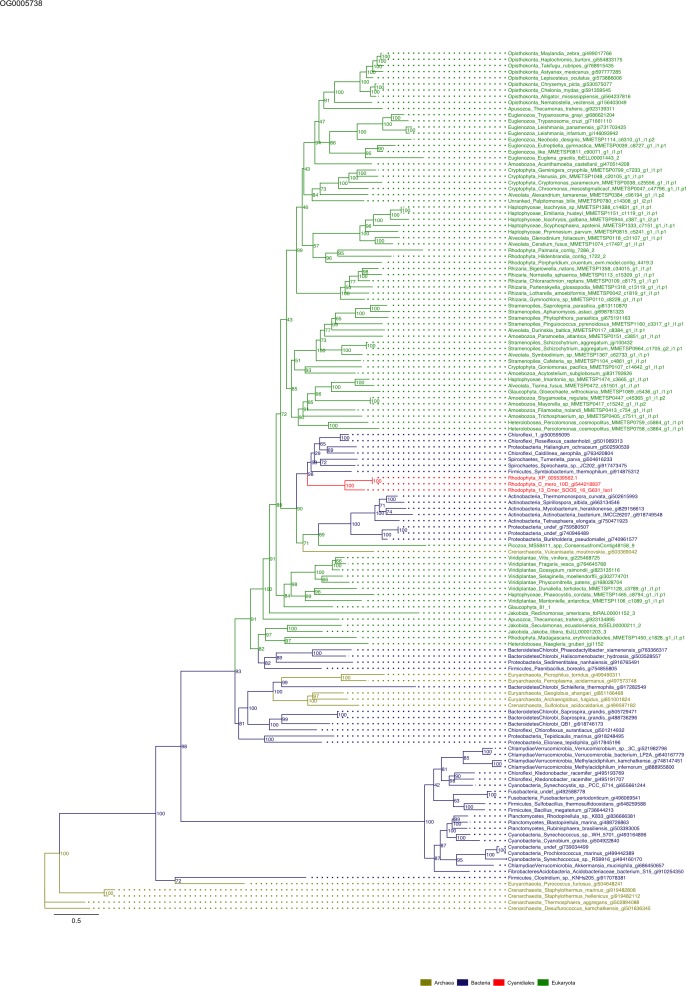
Sequence tree of orthogroup OG0005738.The tree is based on amino acid sequences. Archaea (yellow), Bacteria (blue), Cyanidiales (red), Eukaryotes including other red algae (green). Branches containing Cyanidiales sequences are highlited in red.